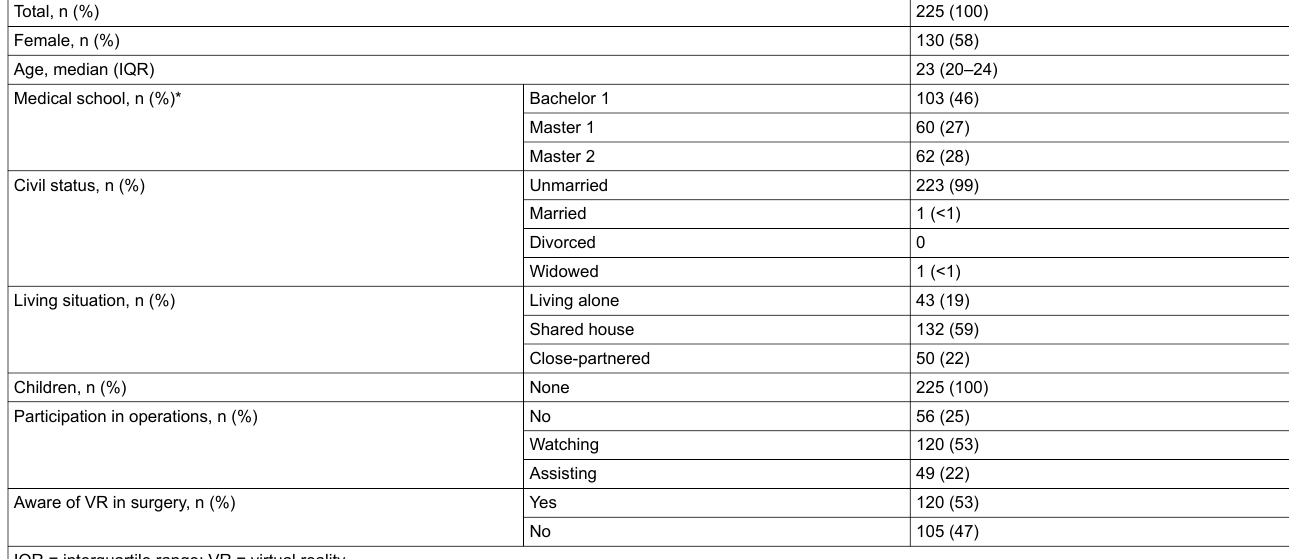
Table 1: Baseline characteristics of participants. Baseline characteristics of participants who responded to the online-questionnaire (n = 225, 87%) *One student from Bachelor 2 and one from Bachelor 3 participated in the Bachelor 1 lecture and were allocated to the Bachelor 1 year in this